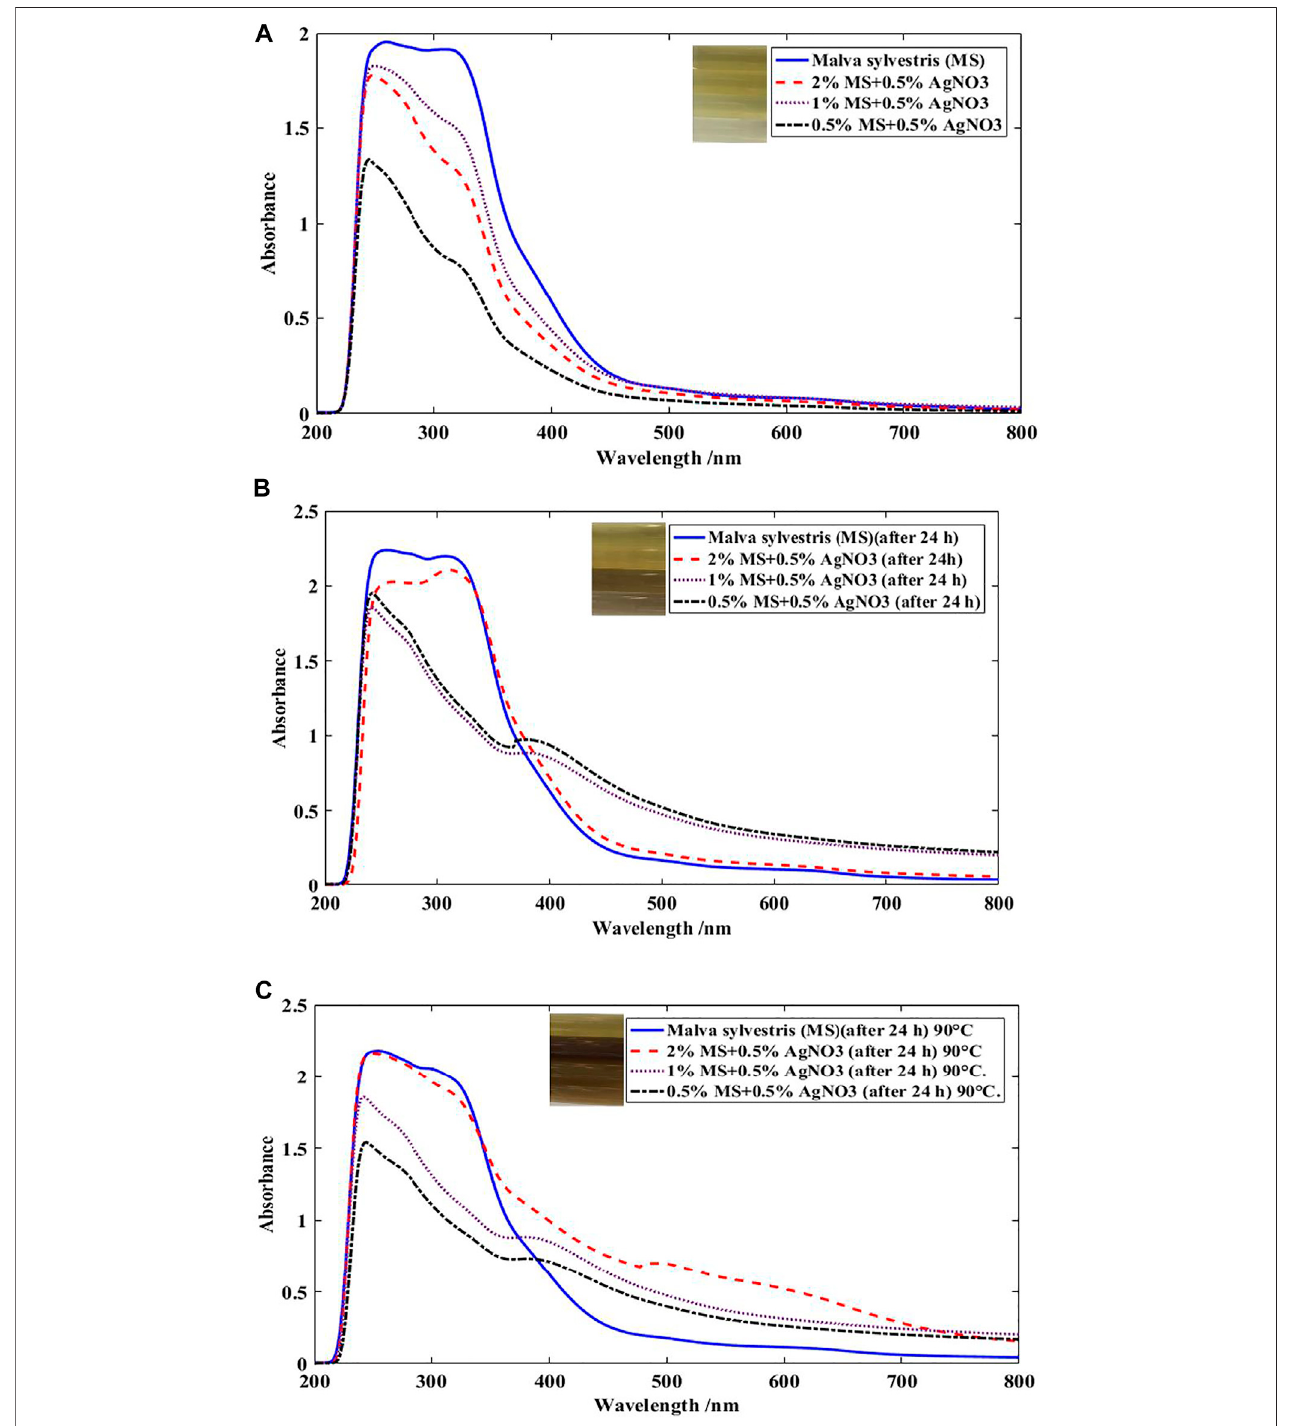
FIGURE 3 | UV-Visible spectra of MS extract at various concentrations in the presence of 0.5% Ag ions (A) at room temperature after 2 – 3 min, (B) at ambient temperature after 24 h, (C) at ambient temperature after 24 h followed by heating at boiling for 1 h